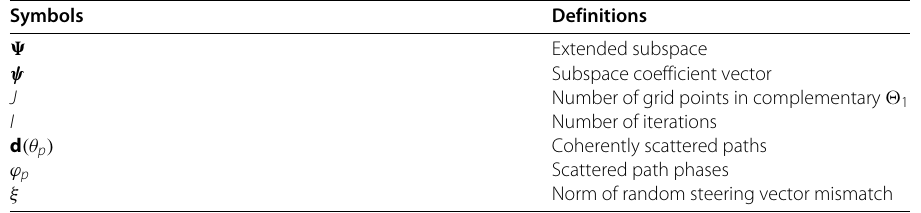
Table 1 The definitions of the symbols used in the paper ( Continued ) Symbols